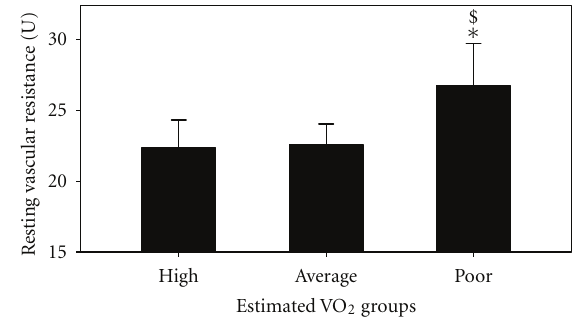
Figure 4: Resting vascular resistance in the poor, average, and high estimated VO 2 max groups. ∗ : P < 0 . 05 versus average and $ : P < 0 . 05 versus high groups.